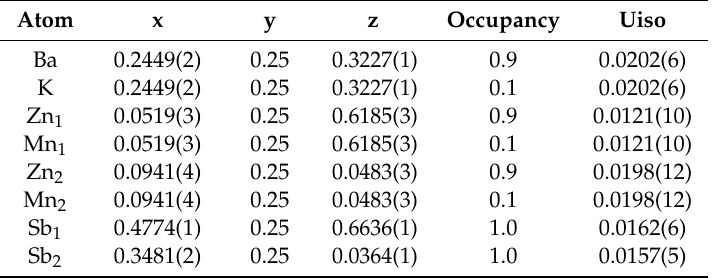
Table 1. Selected structural parameters of (Ba 0.9 K 0.1 )(Zn 0.9 Mn 0.1 ) 2 Sb 2 as determined from Rietveld